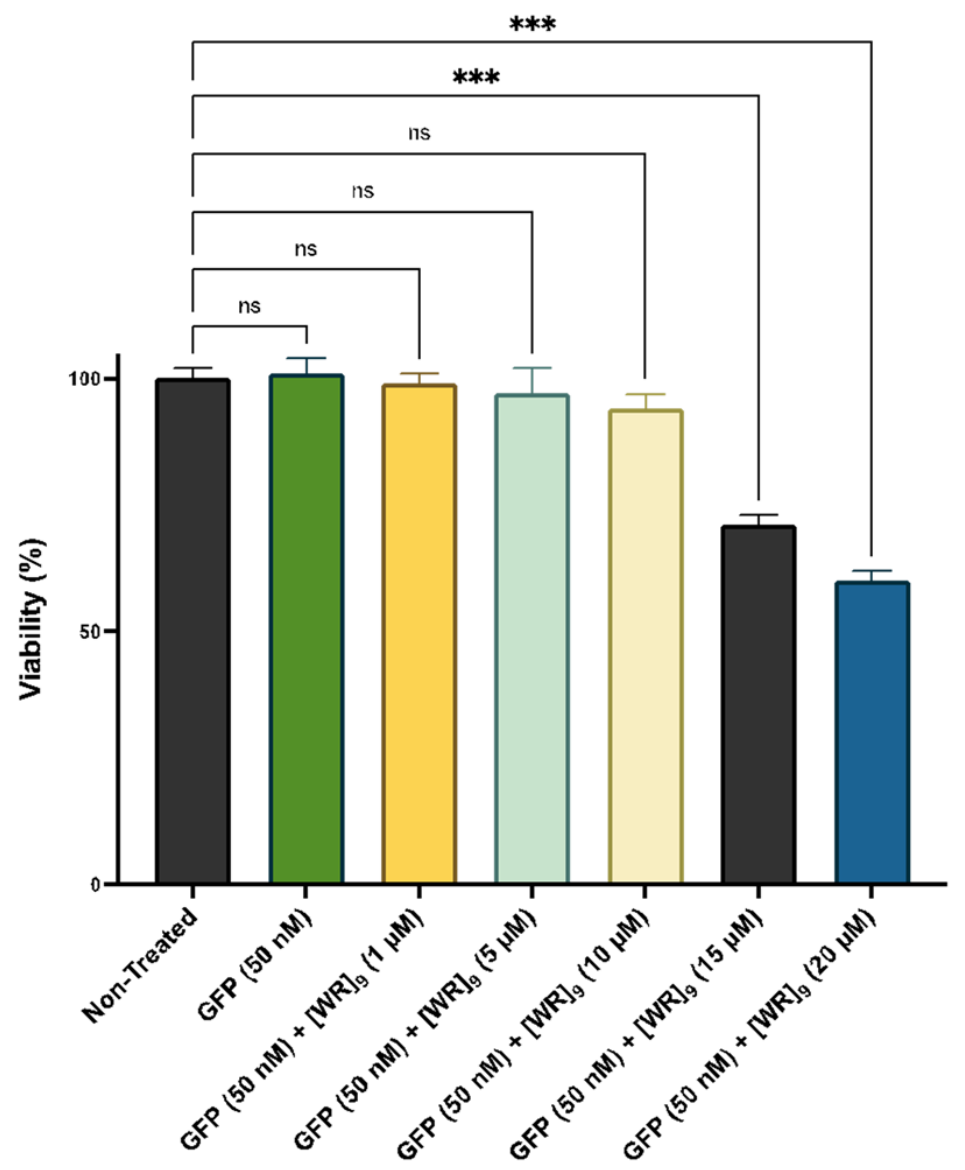
Figure 2. Cytotoxicity of [WR] 9 with GFP (50 nM) physical mixtures at different peptide concentra- tions (1–20 μ M) in breast cancer (MDA-MB-231) cell line after 24 h. The results are mean ± SD ( n = 3) (ns; no significance, *** p < 0.001 treatments vs. Ctrl